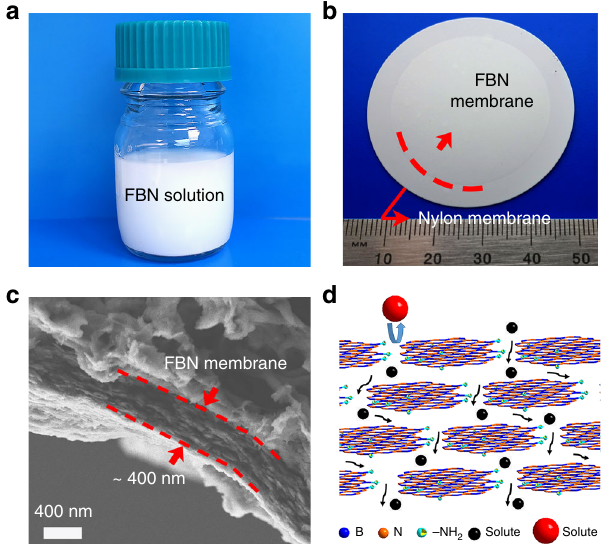
Fig. 1 Preparation of the functionalized boron nitride membrane and solute separation mechanism. a A photograph of the prepared FBN dispersion in water. b A photograph of the prepared FBN on a commercial nylon membrane; the edge of the FBN membrane is shown with a red dotted line. c The cross-sectional SEM image of a FBN-0.4 membrane. d Illustration of the solute separation